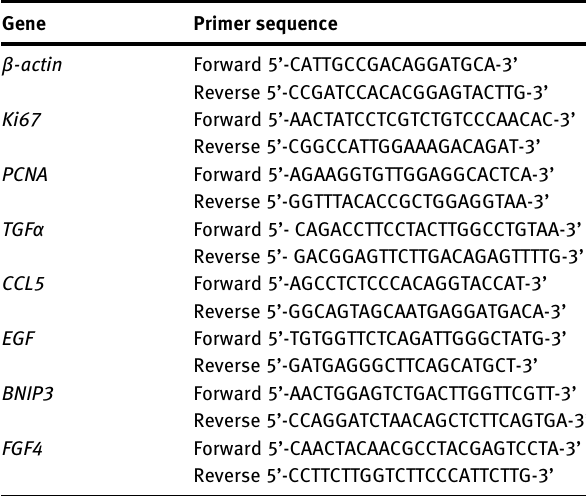
Table  : The list of primers used for mRNA expression analysis of cell proliferation- and migration-related genes by real-time PCR in this study.